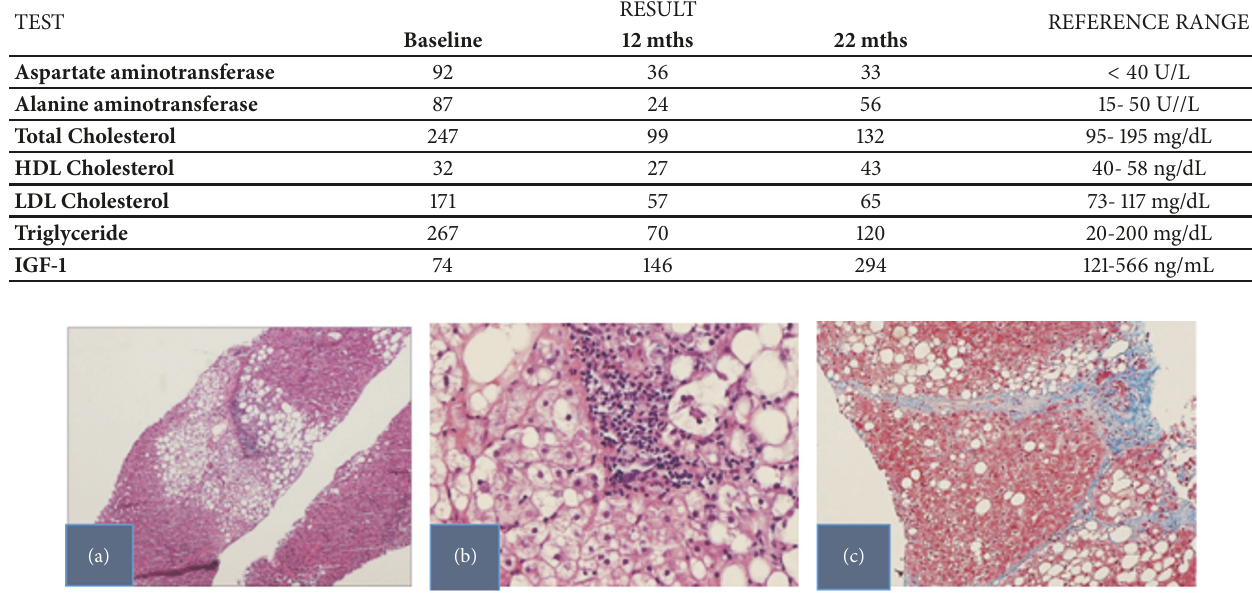
Figure 2: Slides from the patient’s liver biopsy. (a) Low power liver section, ( b ) ballooning hepatocyte degeneration, a feature of hepatic cell death, and (c) intervening fibrous tissue seen as a terminal stage of liver injury. These all constitute steatohepatis with moderate steatosis.